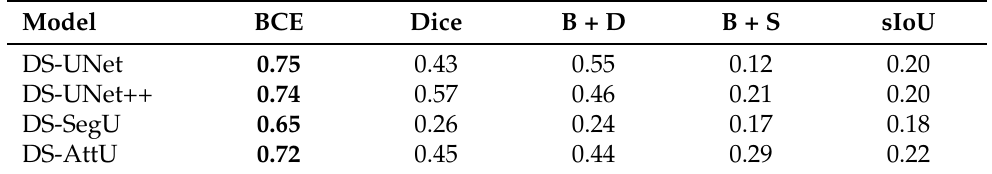
Table 1. Performances in terms of IoU for the binary-class backbones trained with different loss functions. The best loss configuration for each model is highlighted in